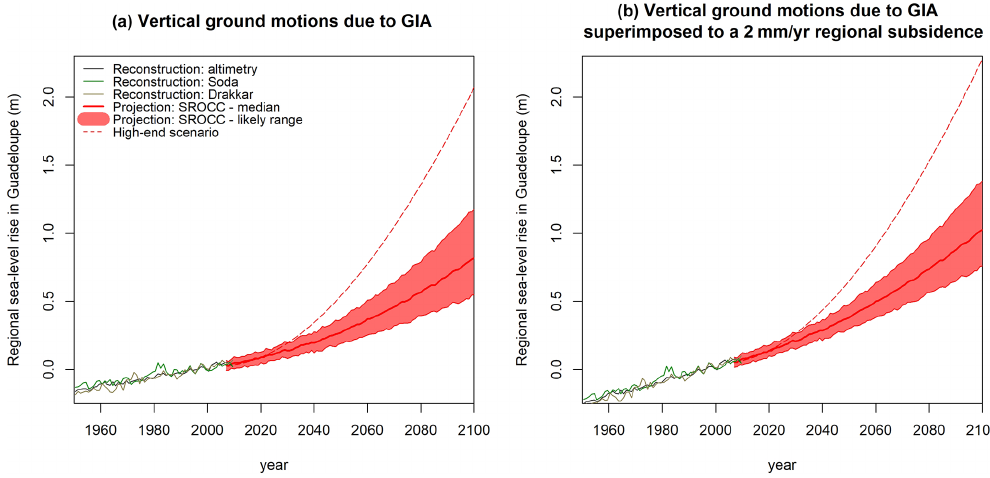
Figure 3. Sea-level reconstructions and projections for Guadeloupe, with respect to 1986–2005: (a) assuming vertical ground motions are due to GIA only and (b) assuming an additional regional subsidence of 2mm/yr. The three reconstructions refer to those presented in Palanisamy et al. (2012). The projections are regional implications of the Special Report on the Ocean and Cryosphere in a Changing Climate (Oppenheimer et al., 2019). The high-end is the regional implication of the high-end projections presented in Thiéblemont et al. (2019).